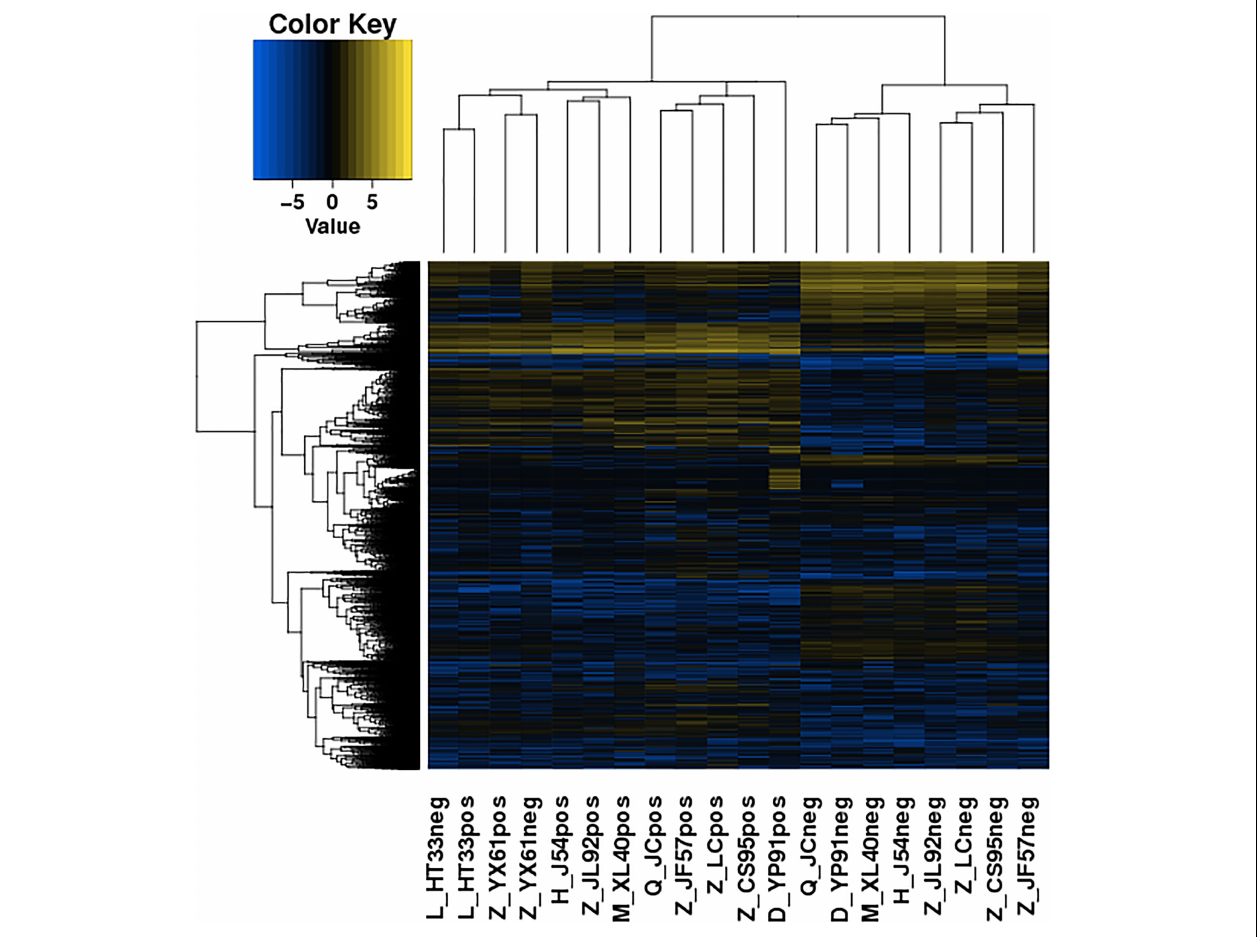
FIGURE 4 | Heatmaps of DE lncRNA: According to the expression of DE genes in each sample, the logarithm of base 2 was considered, the Euclidean distance was calculated, the system clustering method (hierarchical cluster) was used, and the clustering results of the sample were obtained. The various colors represent different expression levels. Blue color indicates the lower expression level, and yellow color indicates the higher expression